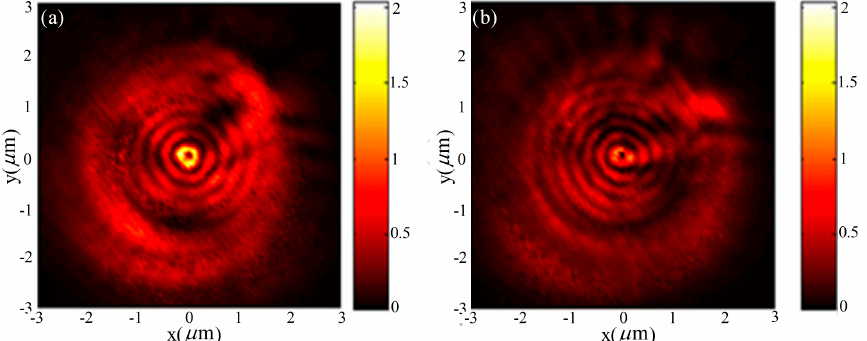
Figure 6. Scanning electron microscope(SEM) image of a plasmonic lens that consists of a spirally-arranged triangular sub-aperture array etched into a gold film ( a ) and a hybrid spiral plasmonic lens combining the array of triangular apertures with single-turn ASS ( b ) fabricated with focused ion beam (FIB) milling. Reproduced with permission from [46]. Copyright Optical Society of America, 2012.